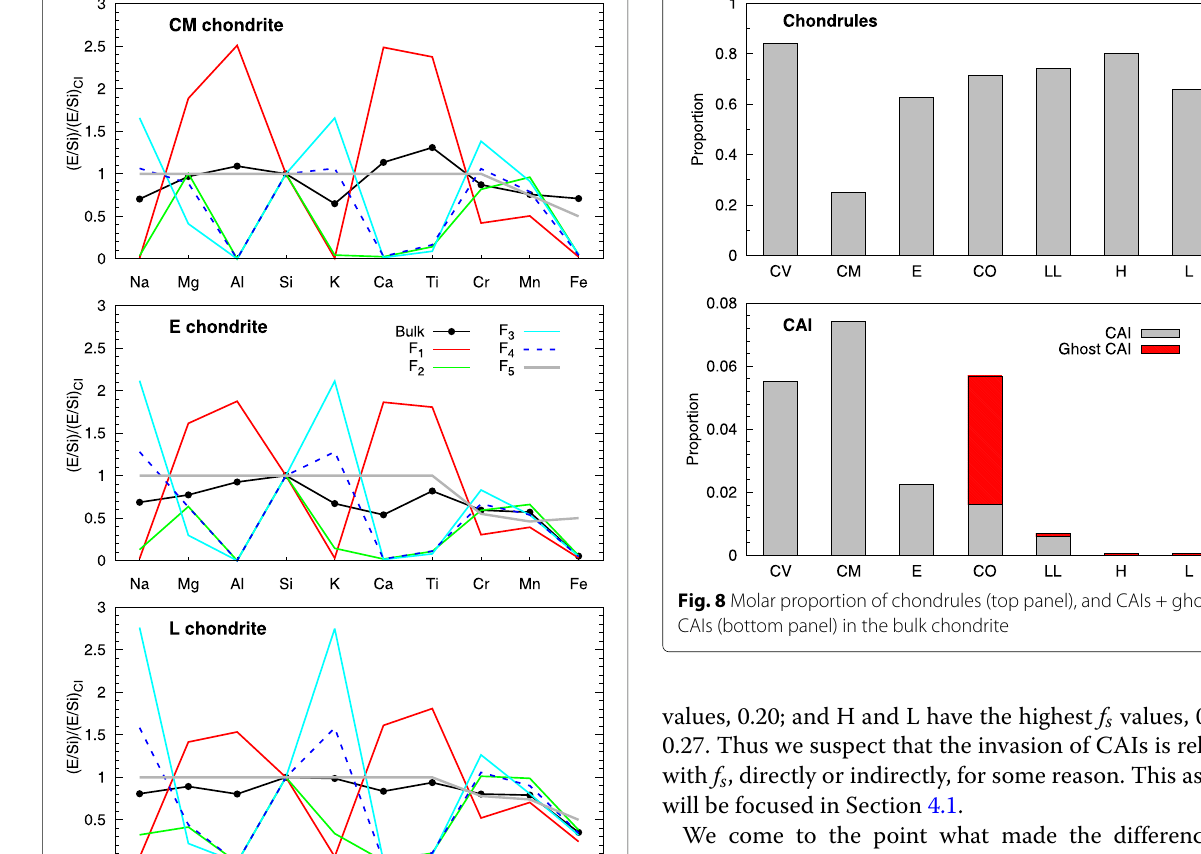
values, 0.20; and H and L have the highest f s values,